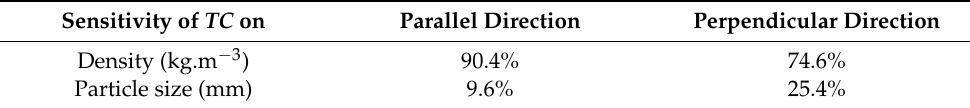
Table 4. Sensitivity coefficients for TC for both vertical and horizontal